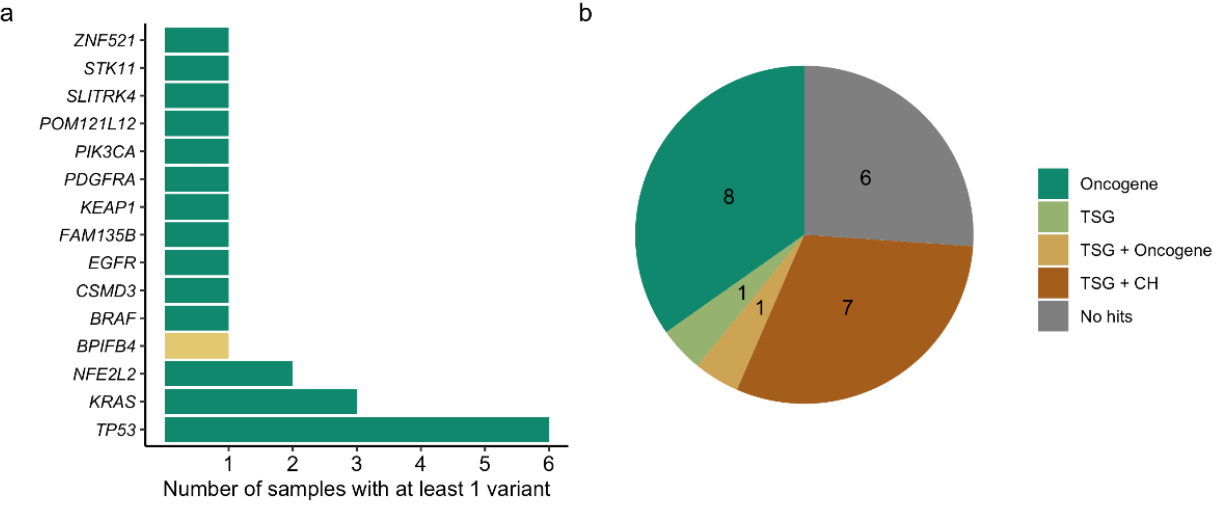
Figure 3. The majority of the somatic variant calls are situated in cancer driver genes. ( a ) Genes with at least one variant reported in control (yellow) and cancer (green) patients’ samples. ( b ) Number of variants reported in a gene with tumor suppressor (TSG) or oncogene prediction or associated with clonal hematopoiesis (CH). Different colors are used for different (combinations of)